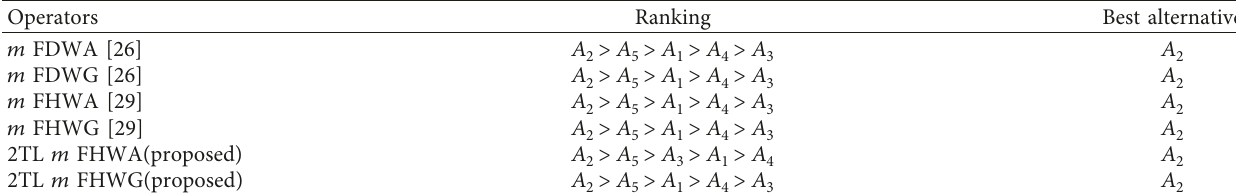
Table 10: Comparative analysis of proposed operators with existing ones.